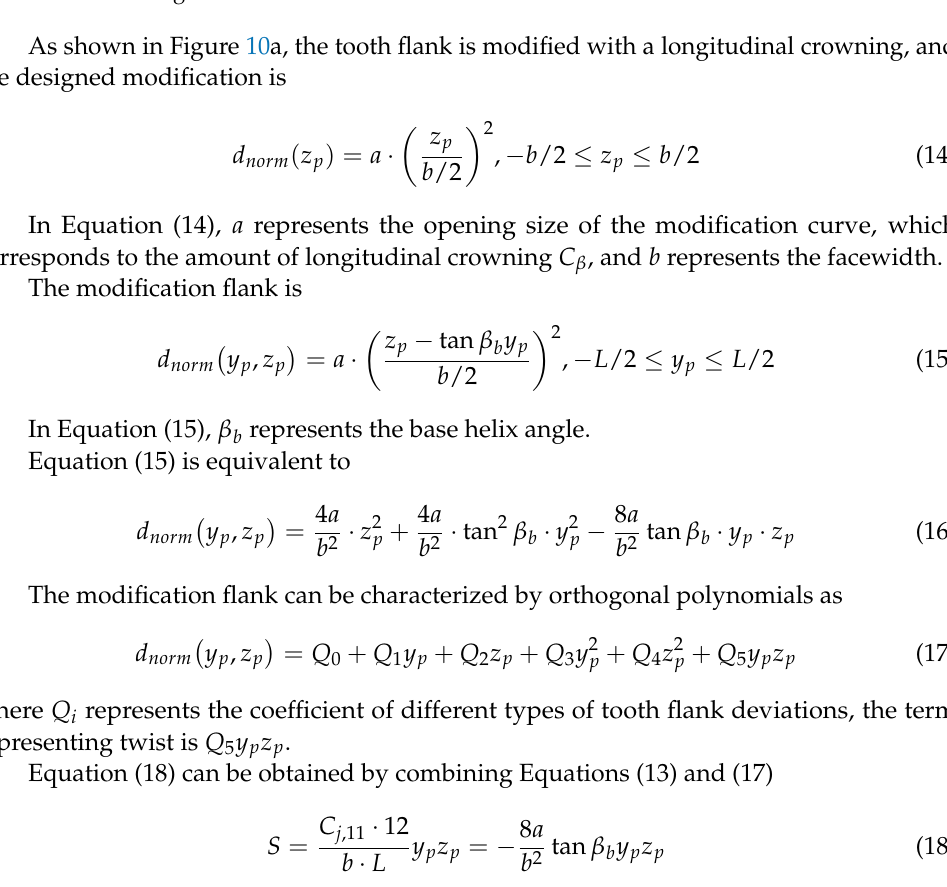
Figure 10. Theoretical modified flank and actual machining flank . ( a ) Theoretical modified flank . ( b ) Actual machining flank .